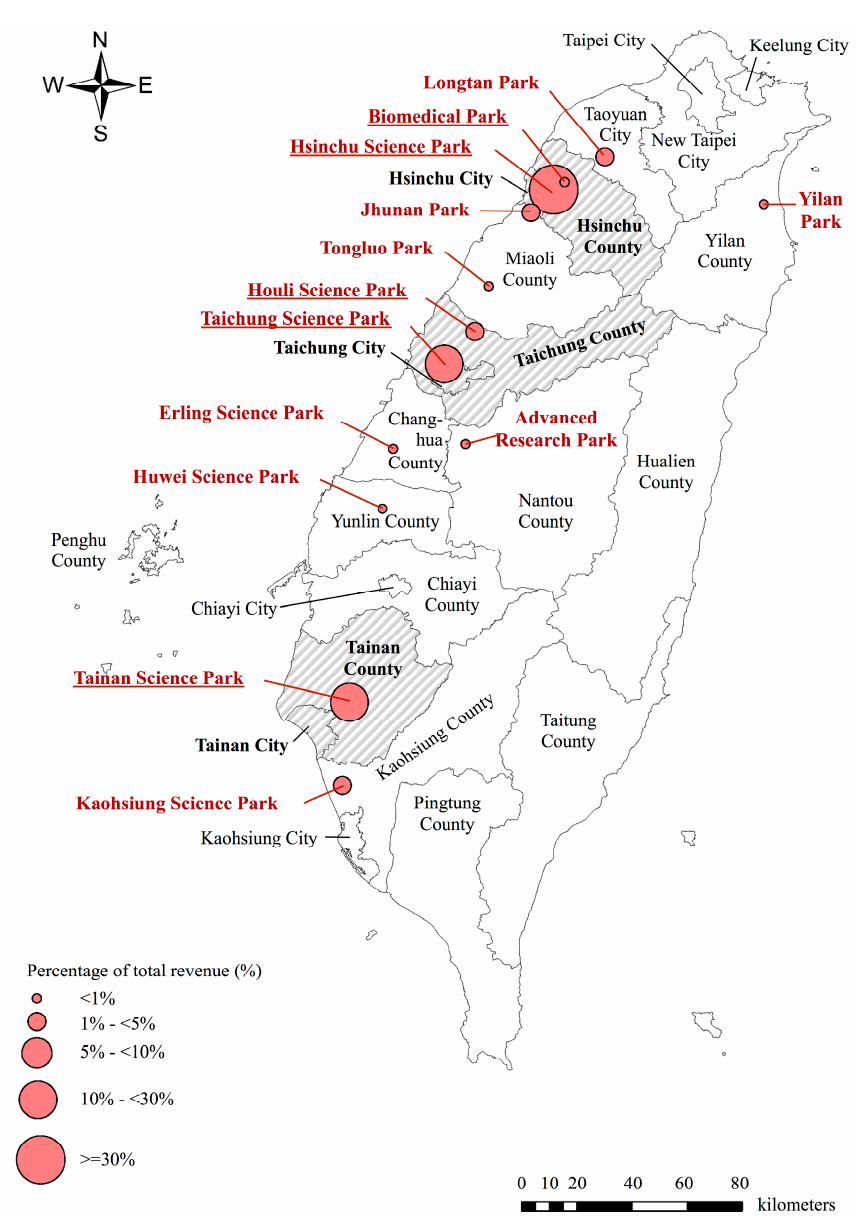
Figure 1. Science park locations in Taiwan, with percentage of total science park revenue, 2015. Circles are drawn in proportion to the percentage of the local science park’s revenue compared with total science park revenue in Taiwan in 2015 [1].